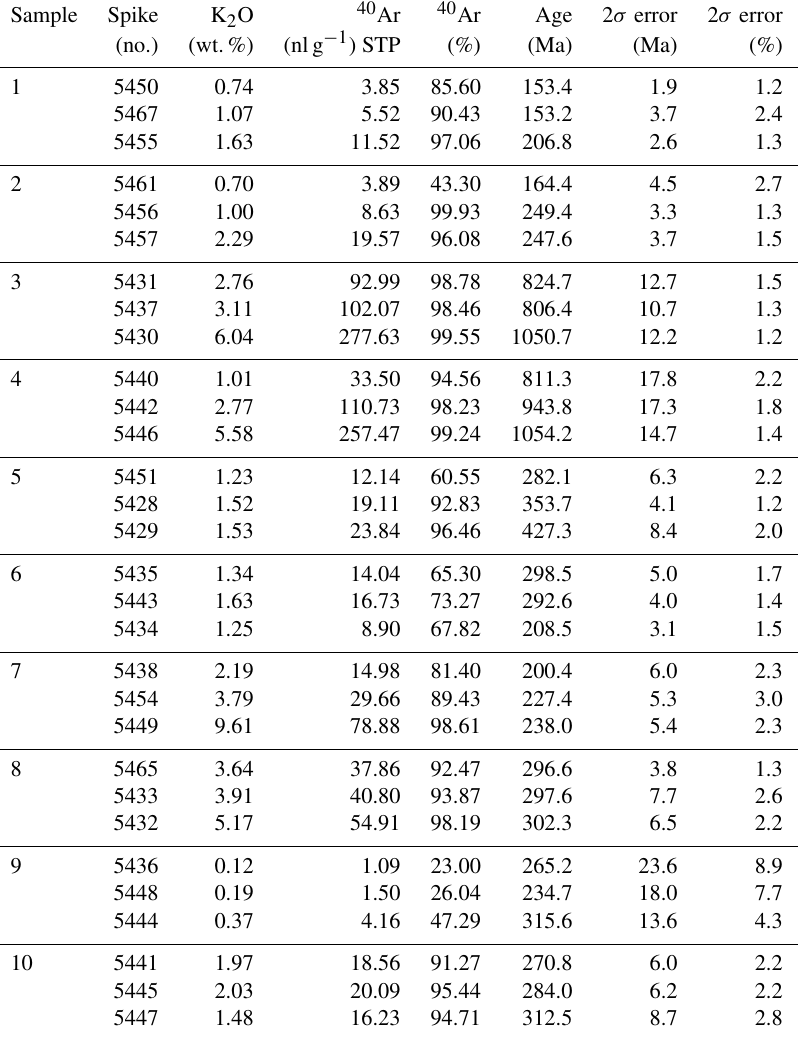
Table 2. K–Ar ages from synkinematic illite in the sampled fault gouges.